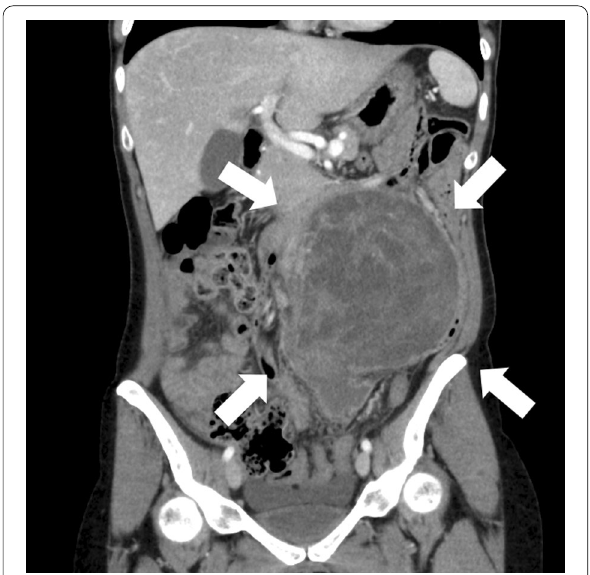
Fig. 2 The tumor is located in the upper left abdomen (arrow) and directly invades the descending colon and intestine. Part of the tumor is torn and ascites is detected around the